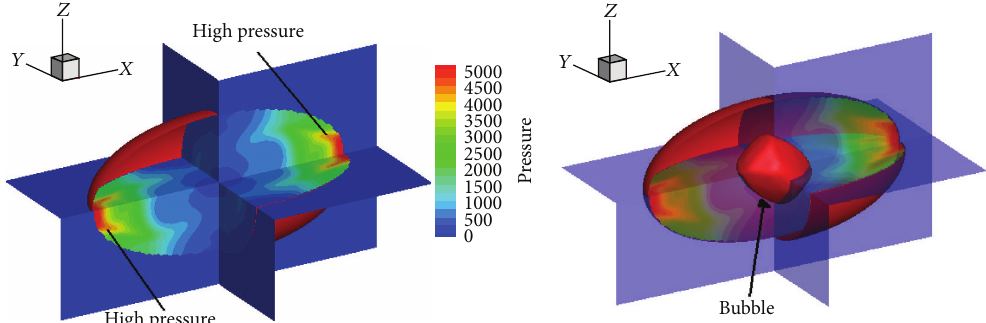
Figure 18: Numerical results by GFM-based algorithm at 𝑡 = 0.644 ms. Left: pressure cloud pictures, right: bubble shape (Case